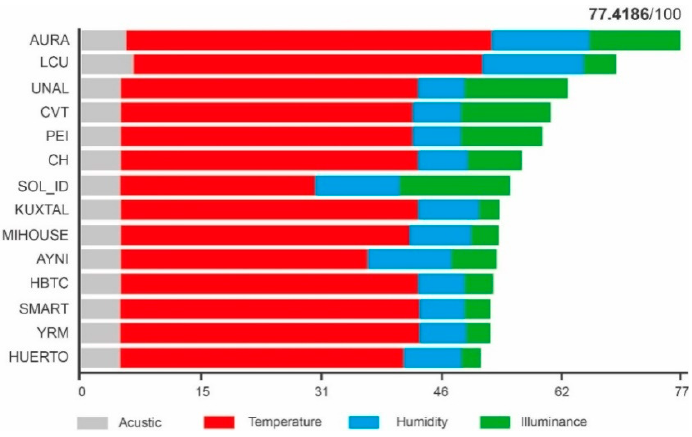
Figure 19. Graph of results by teams of the “Comfort Conditions” test.